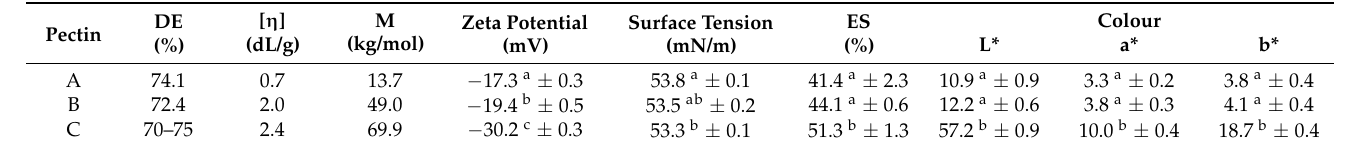
Table 2. Physicochemical properties of pectins A, B and C. Pectins A and B were extracted from orange peels using MAE (620 W, 1:25 w/v , 3 min) and UMAE (50/850 W, 1:20 w/v , 30/3 min),